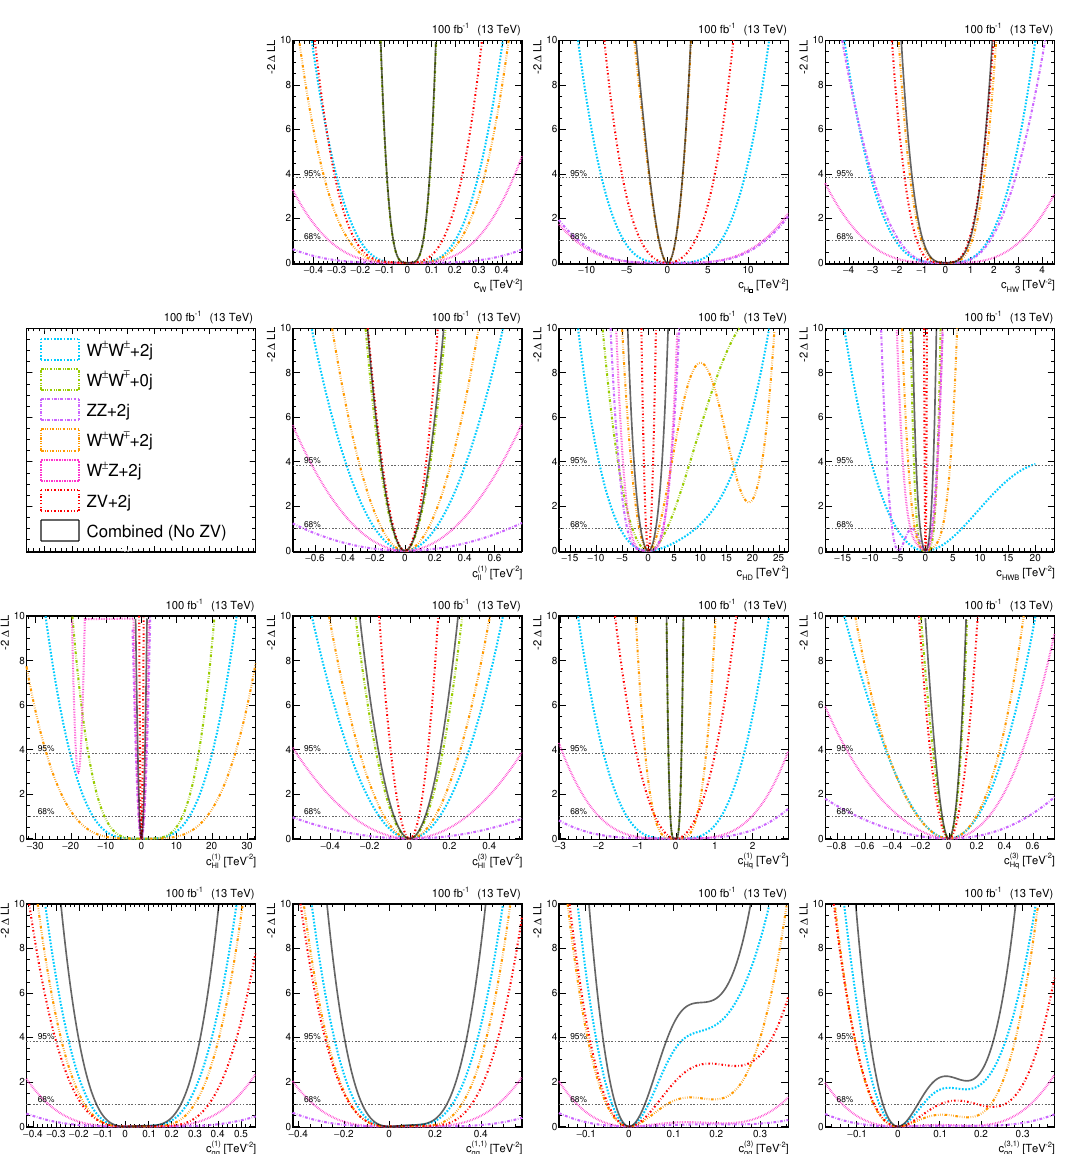
Figure 2 . Profiles of − 2∆ log L reported for the individual channels (colored lines) and their combination (solid black line, excluding ZV+2j) as a function of the Wilson coefficients. Horizontal dashed lines mark the 68% and 95% confidence levels respectively, taken at − 2∆ log L = 1 and − 2∆ log L = 3 . 84 . For each coefficient, the likelihood was built taking, for each channel, the distribution in the most constraining variable at 68% c.l. (see table 5). Only the shown Wilson coefficient is varied at each time, and the others are set to 0. The sensitivity estimate for the OSWW+2j, WZ+2j, ZZ+2j and ZV+2j channels includes contributions from the respective QCD induced